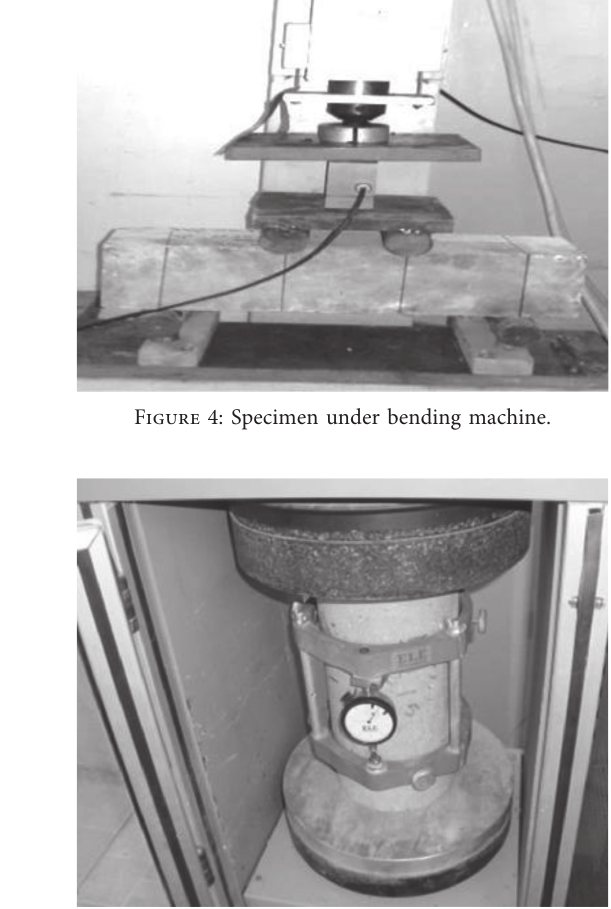
Figure 5: Specimen prepared for the modulus of elasticity